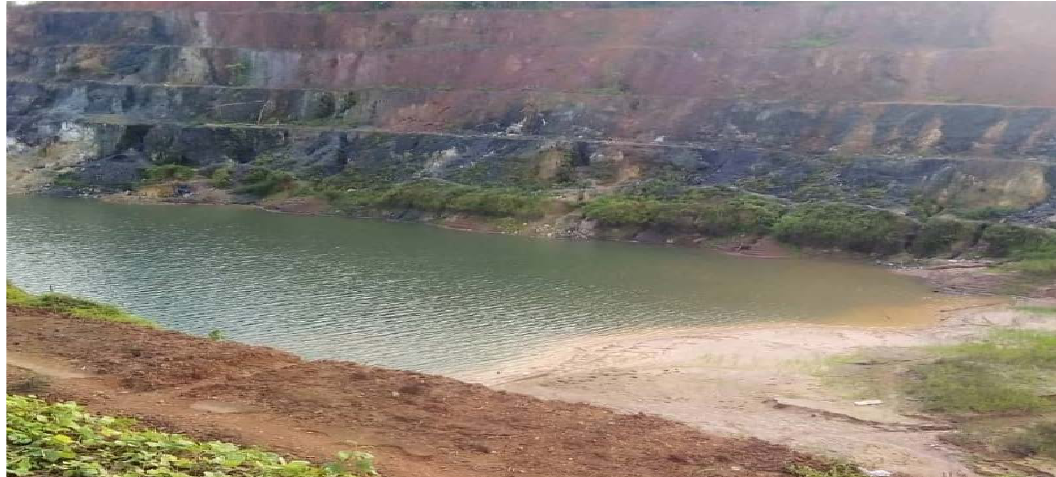
Figure 10. An old pit filled with stagnant water (Salman-Akango pit), August (2020).